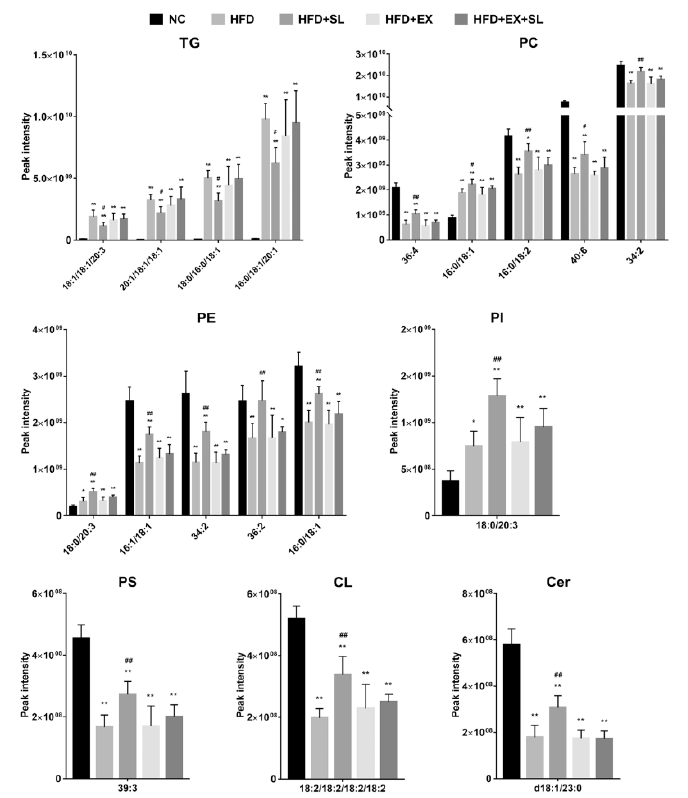
Figure 5. Heatmap of the differential lipid species among the five groups. Red denotes a relative increase, and green denotes a relative decrease.